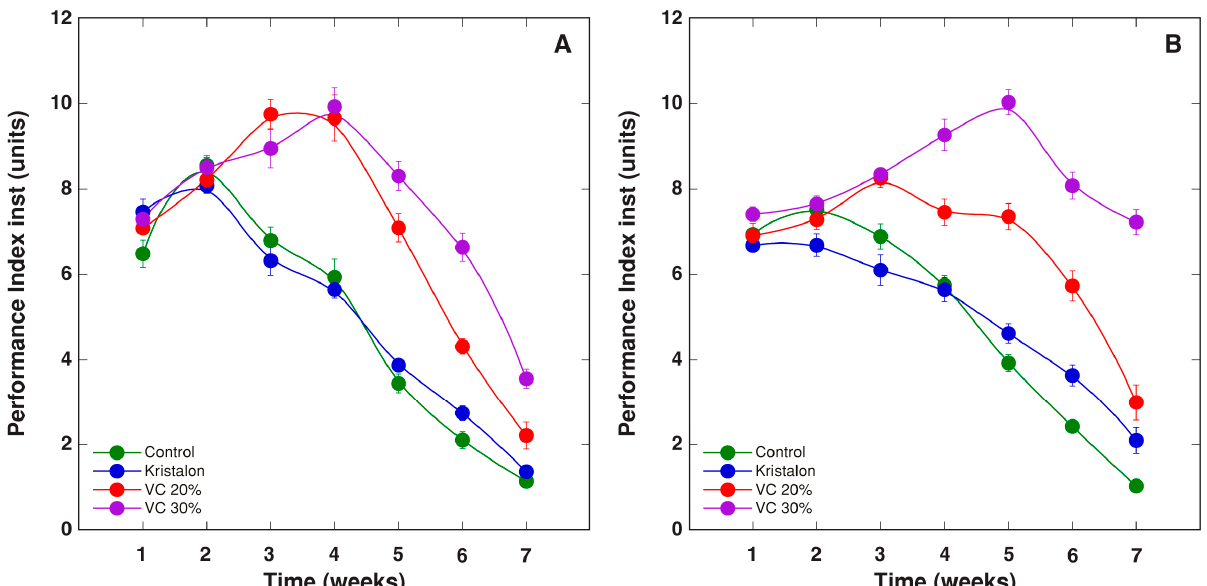
Figure 10. Changes of chlorophyll a fluorescence parameter F v /F 0 as affected by mineral fertilizer (Kristalon) and amendment with vermicompost (VC) at a 20% and 30% ( v / v ) rate in Dracocephalum moldavica plants grown in peat sub- strate ( A ) or commercial garden soil ( B ). Results are means ± SE from five replicates for each treatment, three measure- ments per replicate.